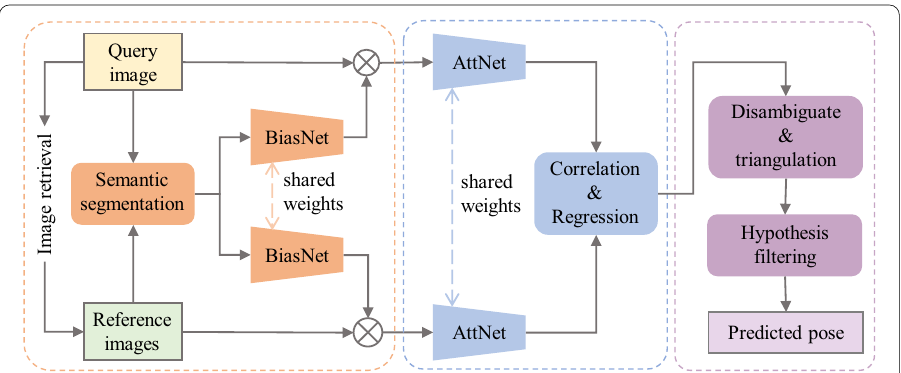
Fig. 1 The proposed relative pose estimate pipeline, with three steps: preparation (orange rectangle), pose regression (blue rectangle), and pose hypothesis filtering (purple rectangle). We use a siamese network architecture to fuse semantic information and extract features, then estimate relative pose by correlating features, and finally predict absolute pose via hypothesis